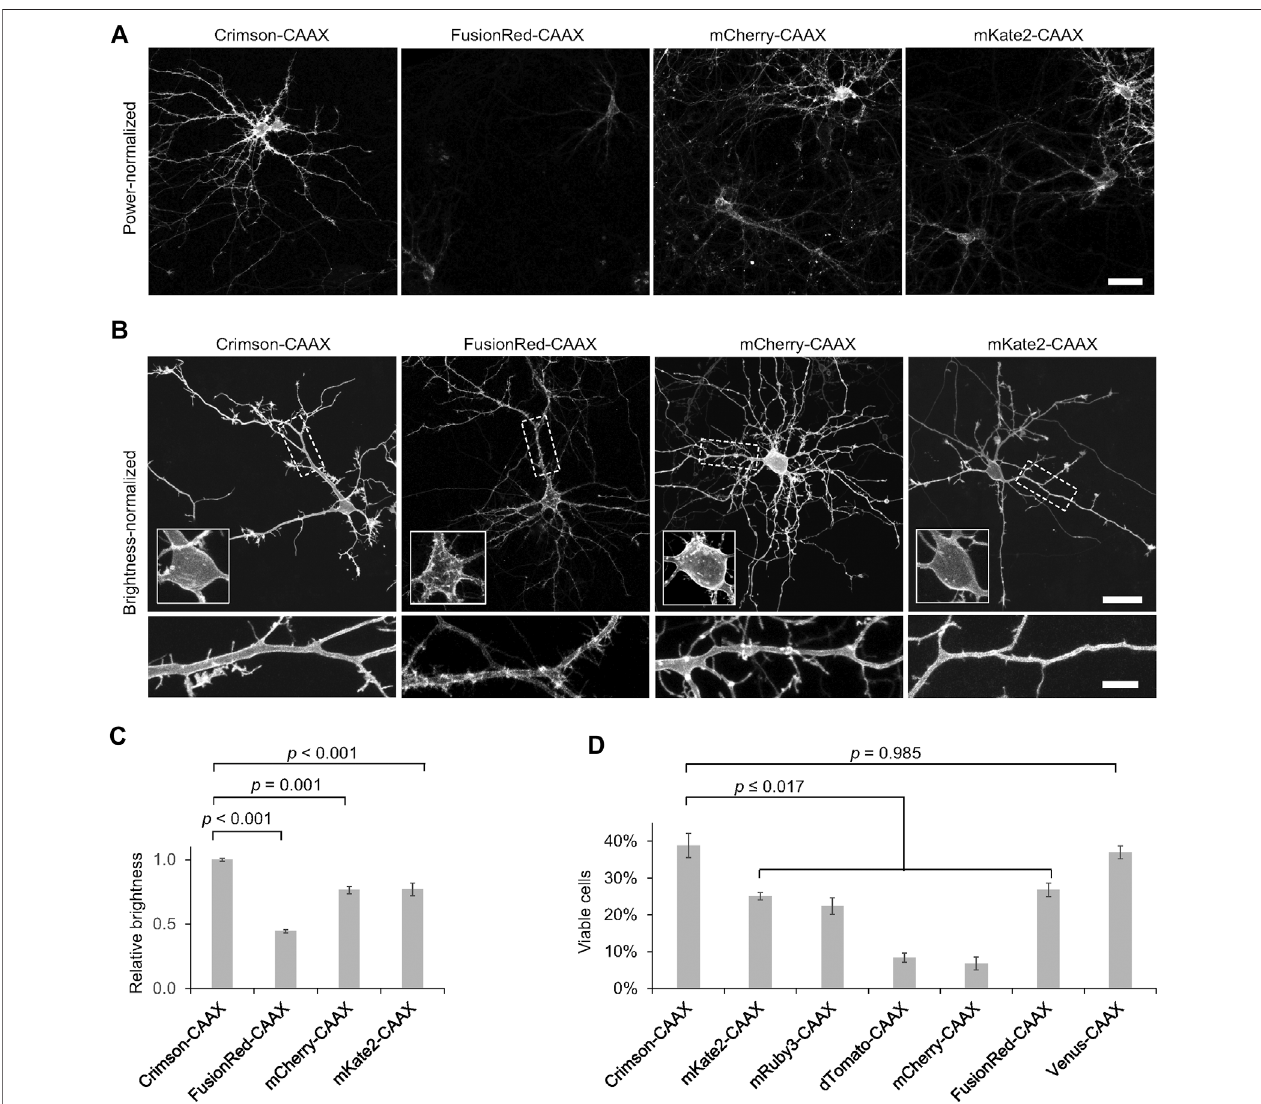
FIGURE4| Crimson-CAAXlabelsthecytoplasmicmembranewellinneurons. (A) BrightnesscomparisonofRFP-CAAXfusionsinrathippocampalneurons3 days post-transfection at 12 DIV. Representative confocal images of transfected neurons acquired and displayed with identical settings are shown. Scale bar = 20 µm. (B) RFP-CAAX fusions visualized with confocal microscopy 3 days post-transfection at 12 DIV, with image brightness adjusted to similar levels for display. Cell bodies are enlarged in the insets within the upper panels. Dendritic segments indicated by the dashed rectangle are enlarged in the lower panels. Scale bar = 20 µm (upper panels) or5 µm(lowerpanels). (C) Quanti fi cationofbrightnessofRFP-CAAXconstructs3 days post-transfectionat12DIV.Errorbars =SEM.Overall p < 0.001byone- factor ANOVA. (D) Quanti fi cation of the percentage of healthy neurons among total transfected neurons 6 days post-transfection at 15 DIV. Crimson-CAAX-expressing neurons demonstrated the highest viability. Error bars = SEM. Overall p < 0.0001 by one-factor ANOVA.